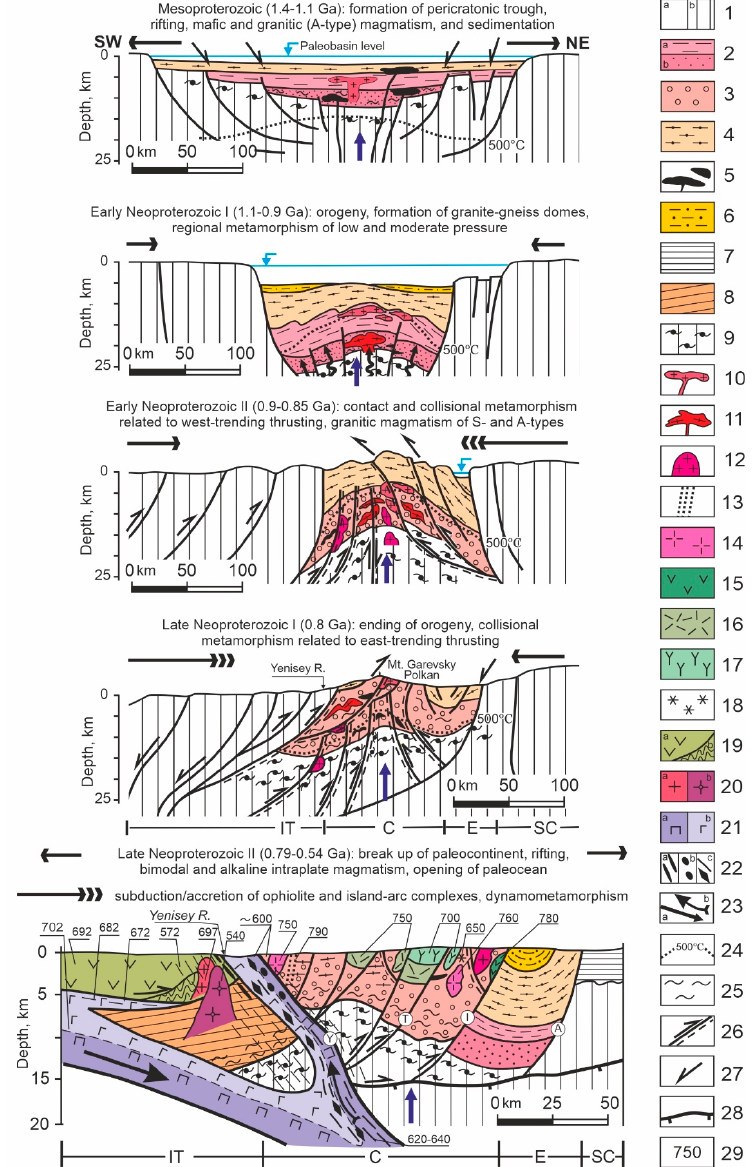
Figure 39. Schematic cross-sections of the study area showing geodynamic events in Meso- and Neoproterozoic evolution of Transangarian Yenisey Ridge. Blocks: C—Central, E—Eastern, IT— Isakovka terrane; SC—Siberian Craton. 1—lithosphere crust: continental (a), oceanic (b); 2—Teya (a), and Garevka and Nemtikha (b) Groups (PP); 3—(PP-MP) unstratified; 4—Sukhopit Group